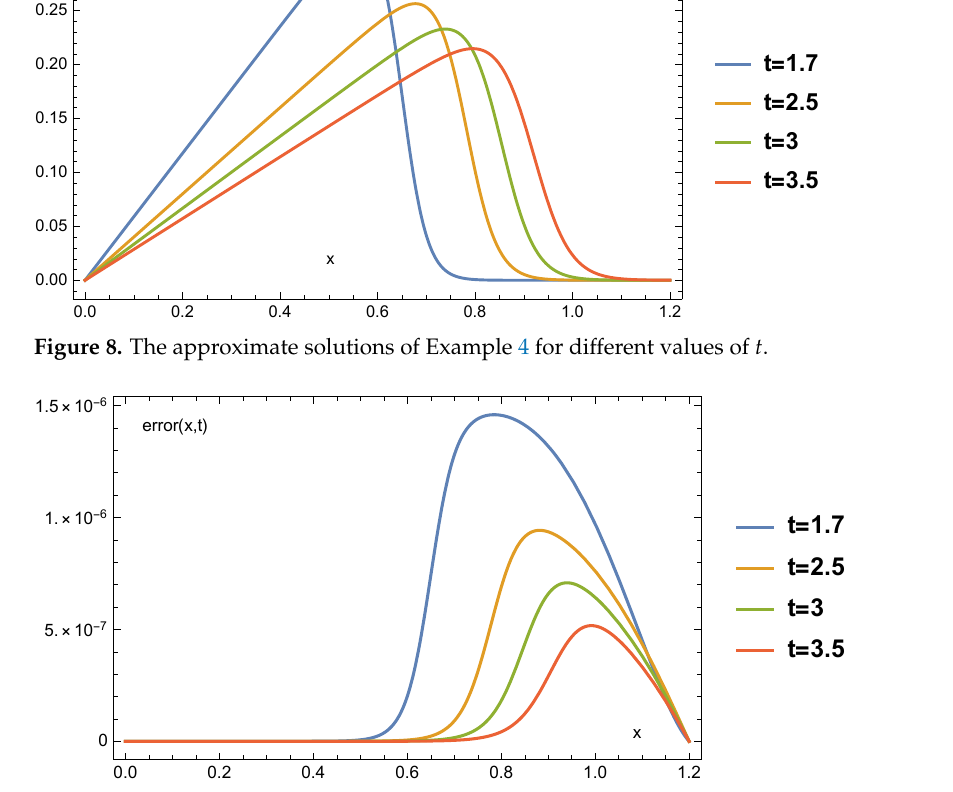
Figure 9. Errors of Example 4 for different values of t